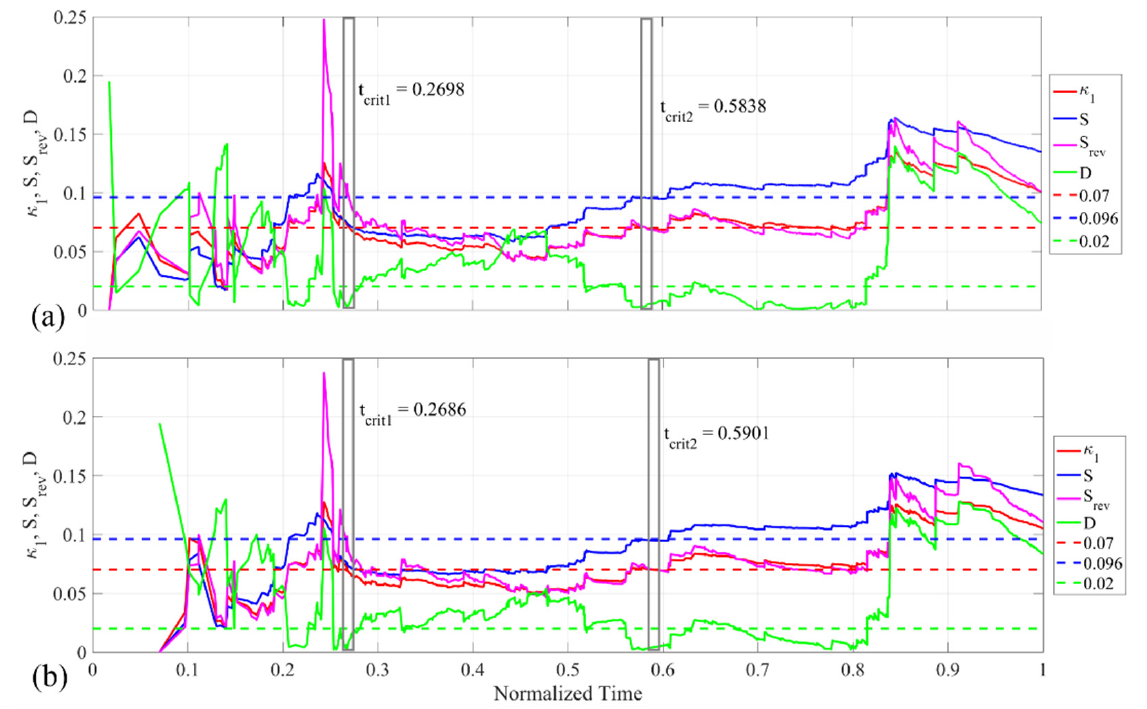
Figure 10. NT analysis of the AE time series for two threshold values ( A max1.5 ) ( b ) 2.0 mV. For ease of interpreting the results, the values for = 0.070 (dashed red), (cid:104) D (cid:105) limit = 10 − 2 (dashed green), entropy limit Su ≈ 0.0966 (dashed blue).are also depicted as horizontal lines.